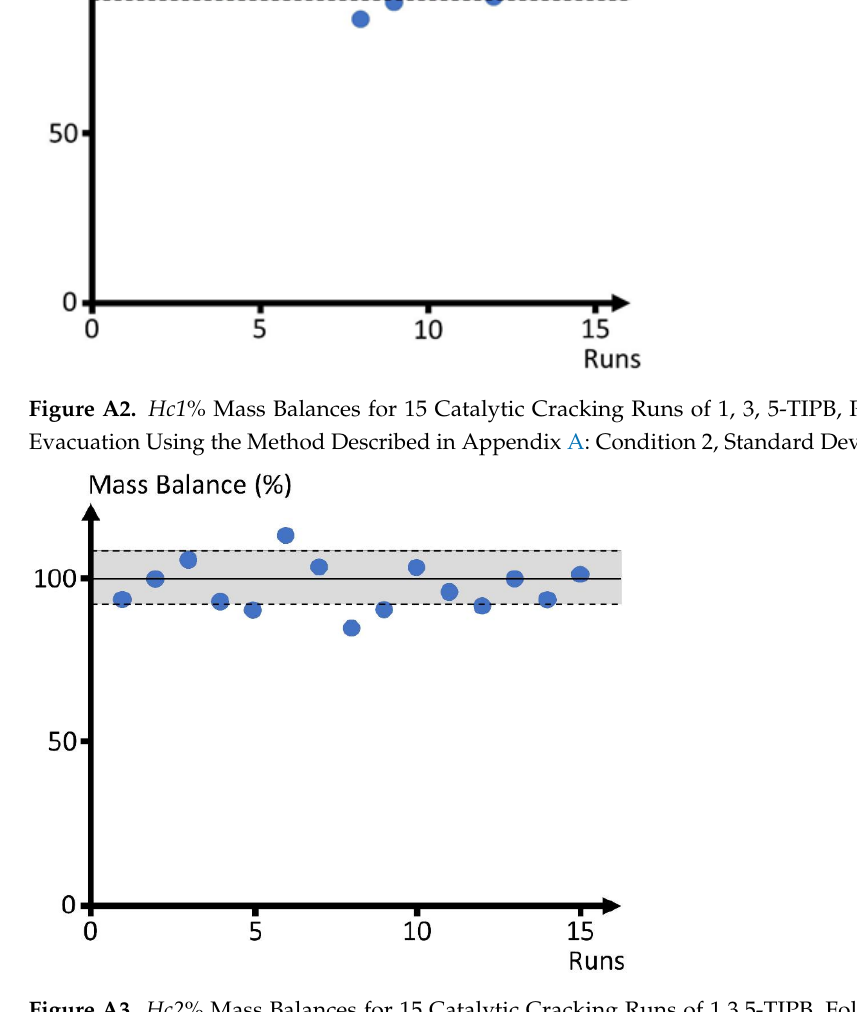
Figure A1. Inert % Mass Balances for 15 Catalytic Cracking Runs of 1, 3, 5-TIPB Using the Method Described in Appendix A. Condition 3, Standard Deviation: ±0.5%.